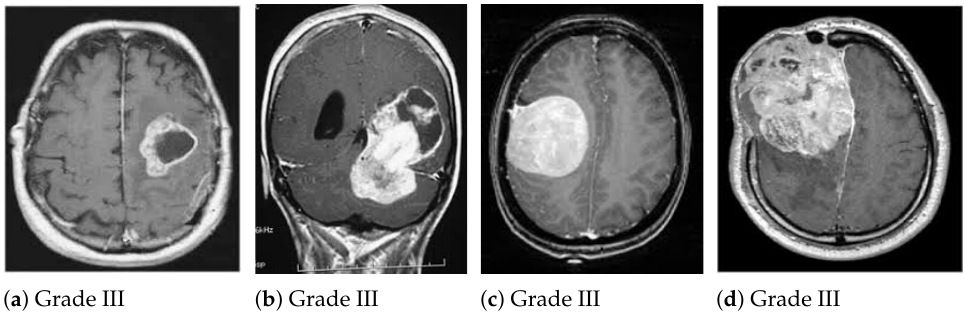
Figure 3. Examples of malignant meningioma brain